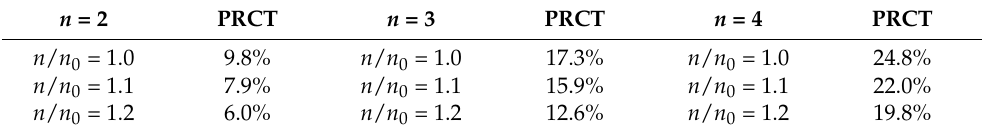
Table 2. Effects of load on the CLC time of